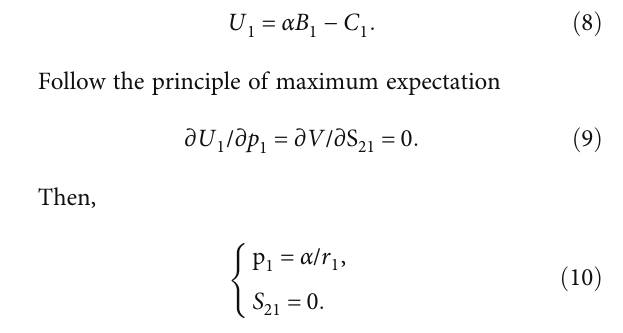
Figure 6: The choice of college